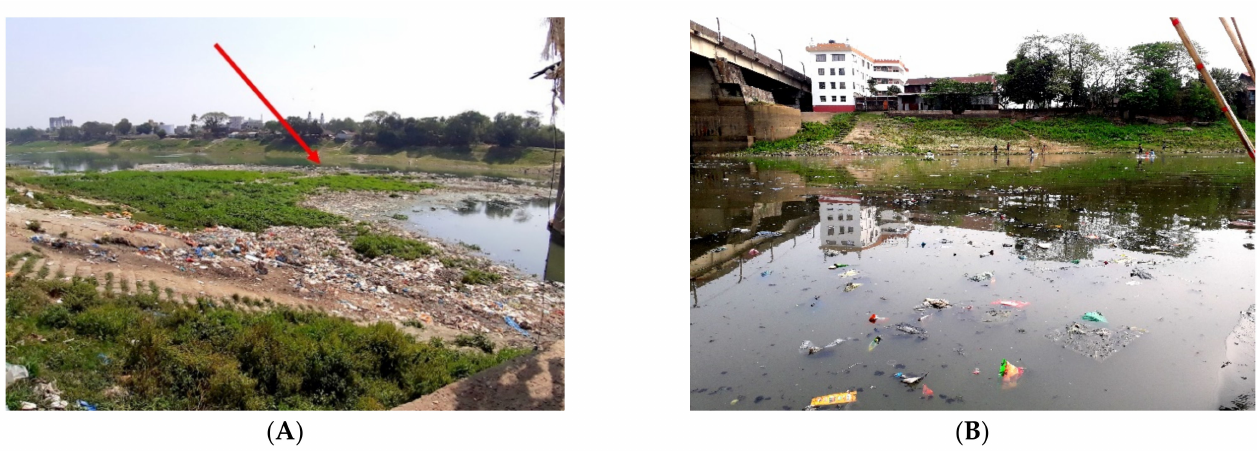
Figure 8. River discharge, rainfall, and water level of the Surma River from 2001 to 2021.